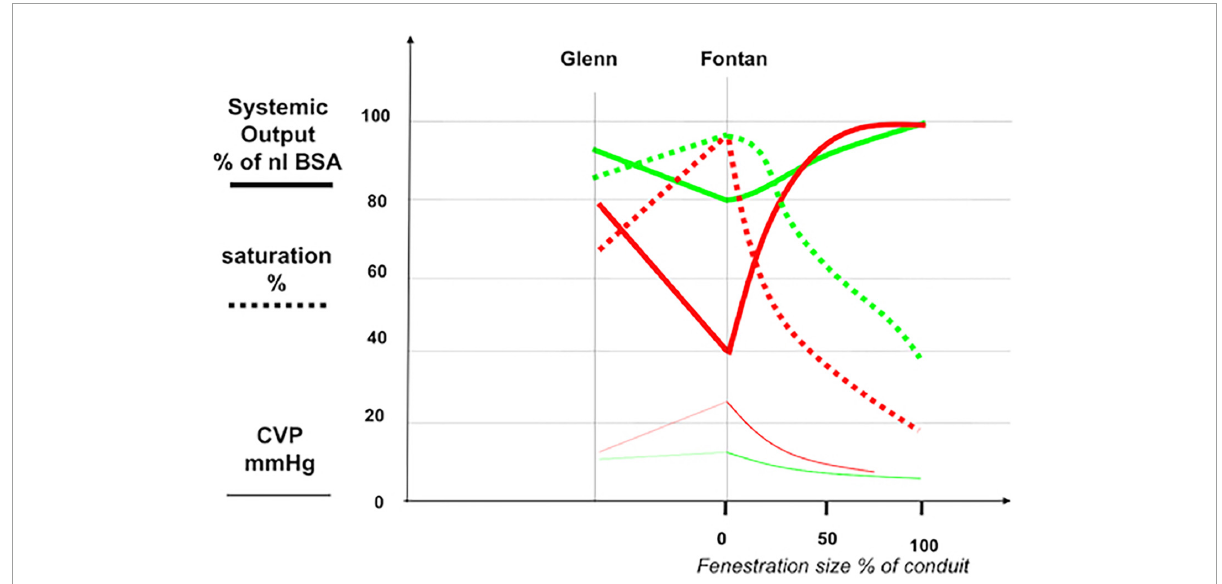
FIGURE3 Effect of various degrees of pulmonary bypassing in a Fontan circuit on systemic output (thick line), saturation (dotted line), and systemic venous congestion (thin line). A “good Fontan” (green or lighter lines) with low neoportal resistance has a cardiac output (solid green line) of about 80% of normal for BSA, with high saturations (dotted green line) and a slightly raised CVP (thin green line). The “bad Fontan” (red lines) with a high neoportal resistance has comparable saturations (dotted red) but with a very low output (solid red) in the presence of a high CVP (thin red). Partial bypassing of the Fontan portal system by a fenestration consistently increases systemic output and lowers venous congestion but may give rise to clinically intolerable degrees of cyanosis (effects of fenestration size can be viewed at the bottom right of the graph). BSA: body surface area; CVP: central venous pressure. Adapted with permission from Gewillig et al. (28).